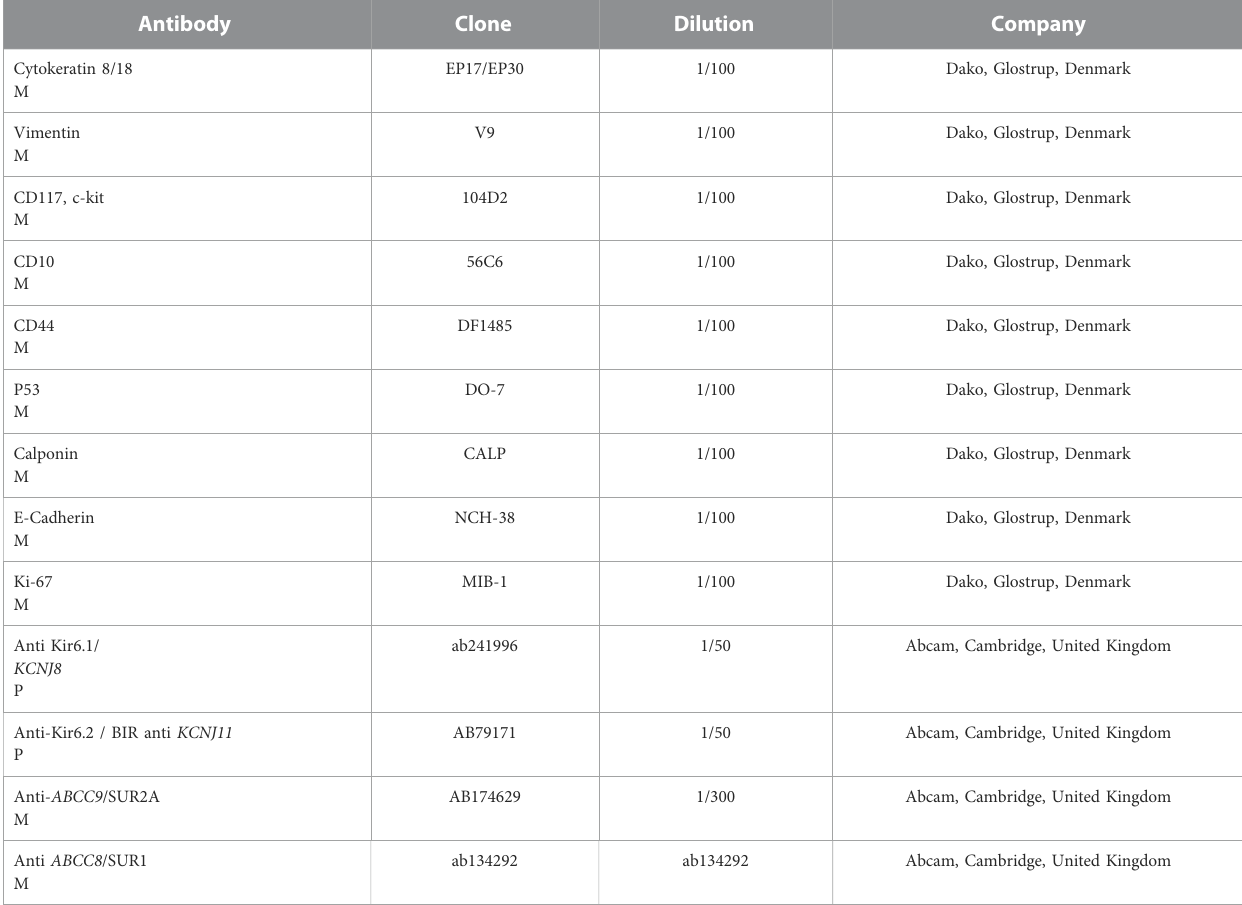
TABLE 1 The immunohistochemical markers were used in the kidney cancer in the rat.